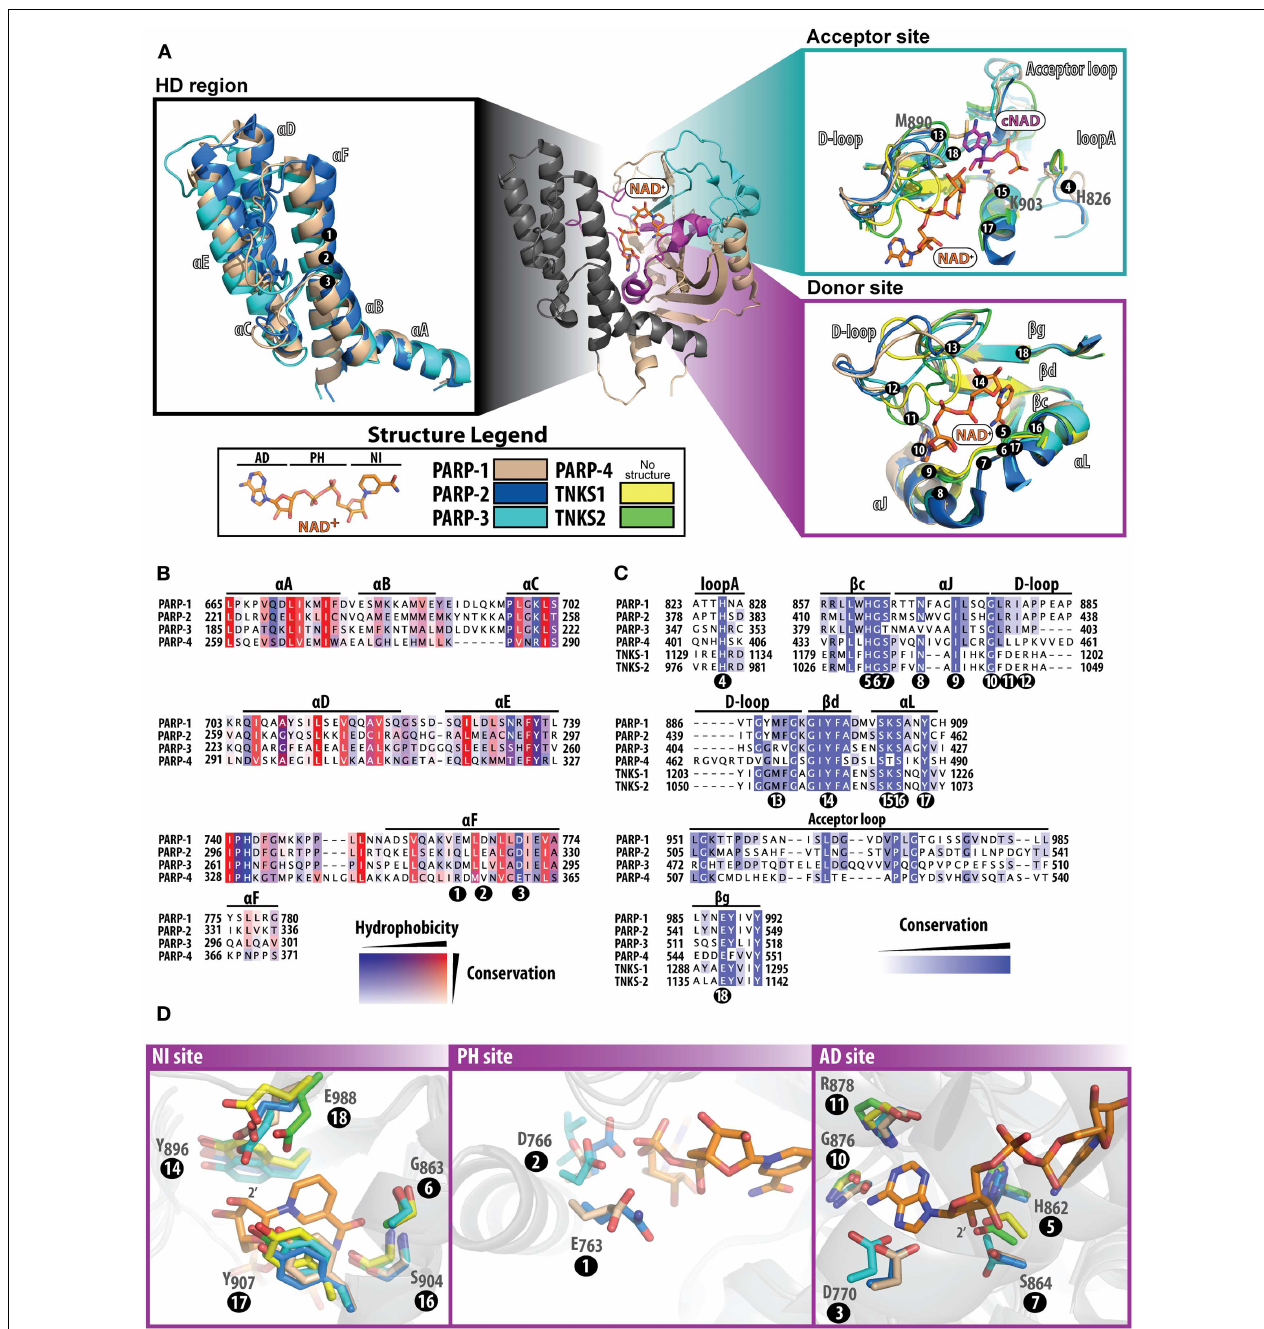
all PARPs, although the acceptor site is much less conserved (acceptor loop and loop A).The D-loop assumes varying structural conformations and is also less conserved, which is an indication of where selectivity may be best achieved.The donor site is composed of three regions that bind to NAD + (D) the NI site (left), the PH site (middle), and the AD site (right). Multiple sequence alignments were carried out using ClustalW2 [(83); www.ebi.ac.uk/Tools/msa/clustalw2/], and the sequences of human PARPs were analyzed using Jalview [(84); www.jalview.org/]. Structures used for comparisons include: PARP-1 (PDB ID: 3GN7), PARP-2 (PDB ID: 3KCZ), PARP-3 (PDB ID: 3FHB),TNKS1 (PDB ID: 2RF5), andTNKS2 (PDB ID: